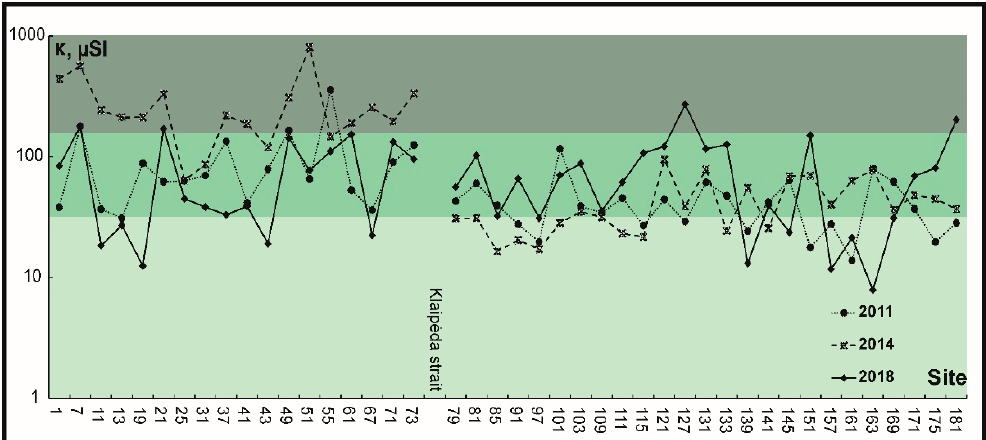
Figure 3. The distribution of magnetic susceptibility values ( κ , μ SI) of the beach sediments along the coast of the south-eastern Baltic Sea coast (Lithuania) in 2011, 2014, and 2018 (the dark green colour field indicate heavy minerals, green—heavy mineral-rich sand and light green—quartz-rich sands).